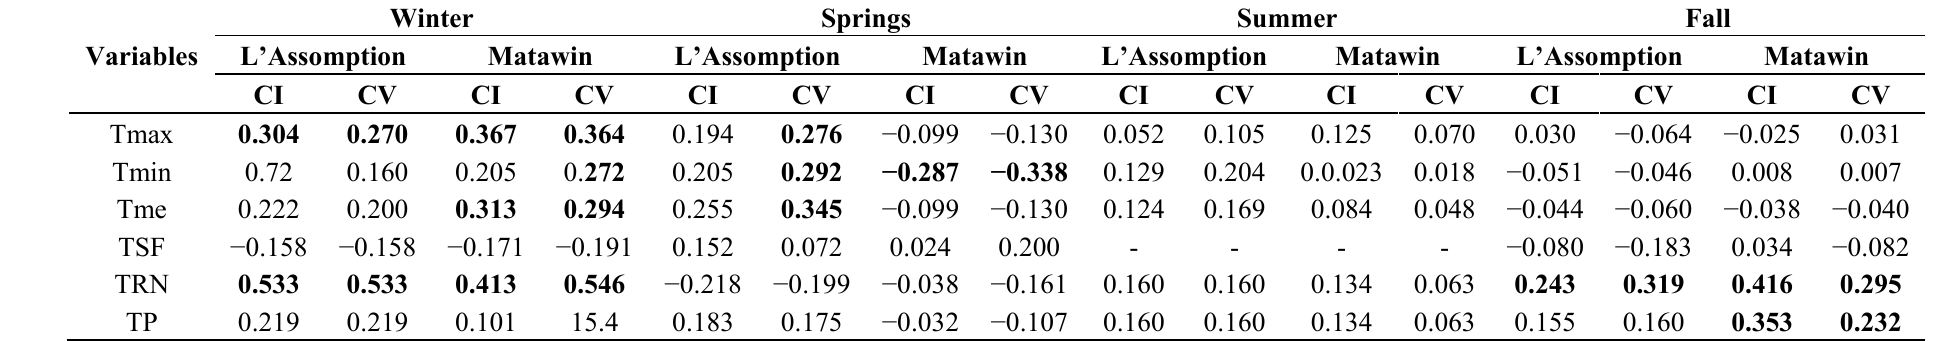
Table 3. Coefficients of correlation calculated between climate variables and seasonal daily flow variability